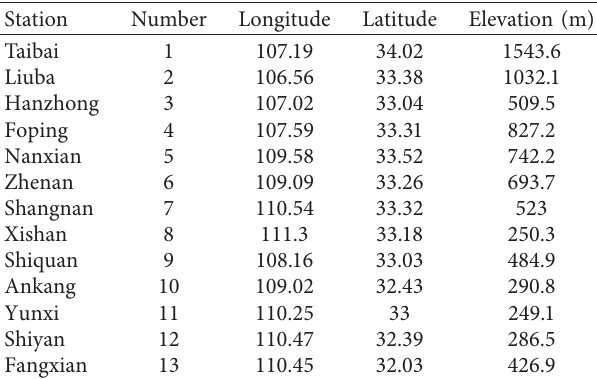
Table 1: Location information of meteorological